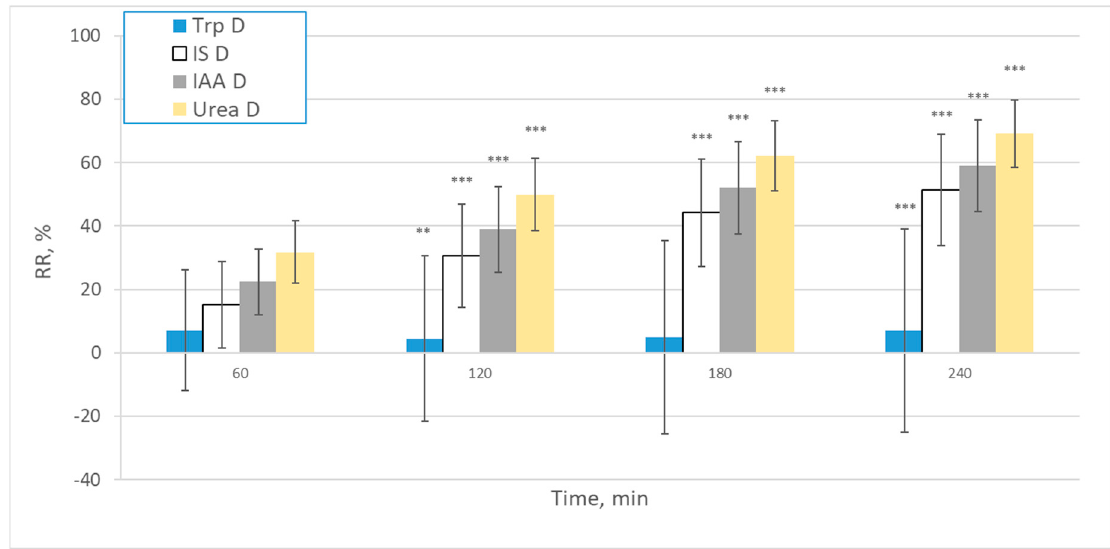
Figure 3. Reduction ratios (RR) at different time points during the dialysis sessions for Trp, IS, IAA and urea calculated from the dialysate values ( n = 244). *** p < 0.001; ** p < 0.01; * p < 0.05 vs. previous timepoint value.